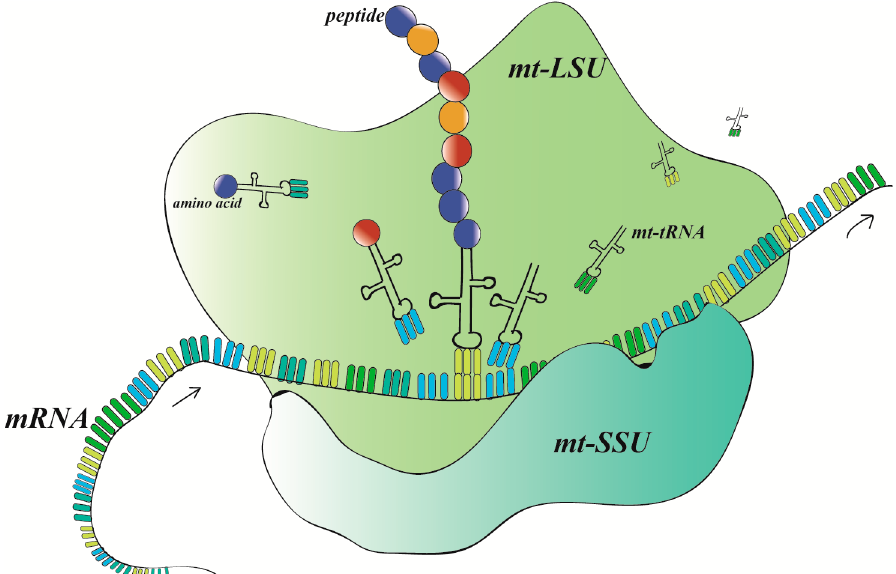
Figure 2. The function of mitochondrial ribosome is to accurately synthesize the polypeptide chain from the mRNA information of mitochondrial DNA transcription.